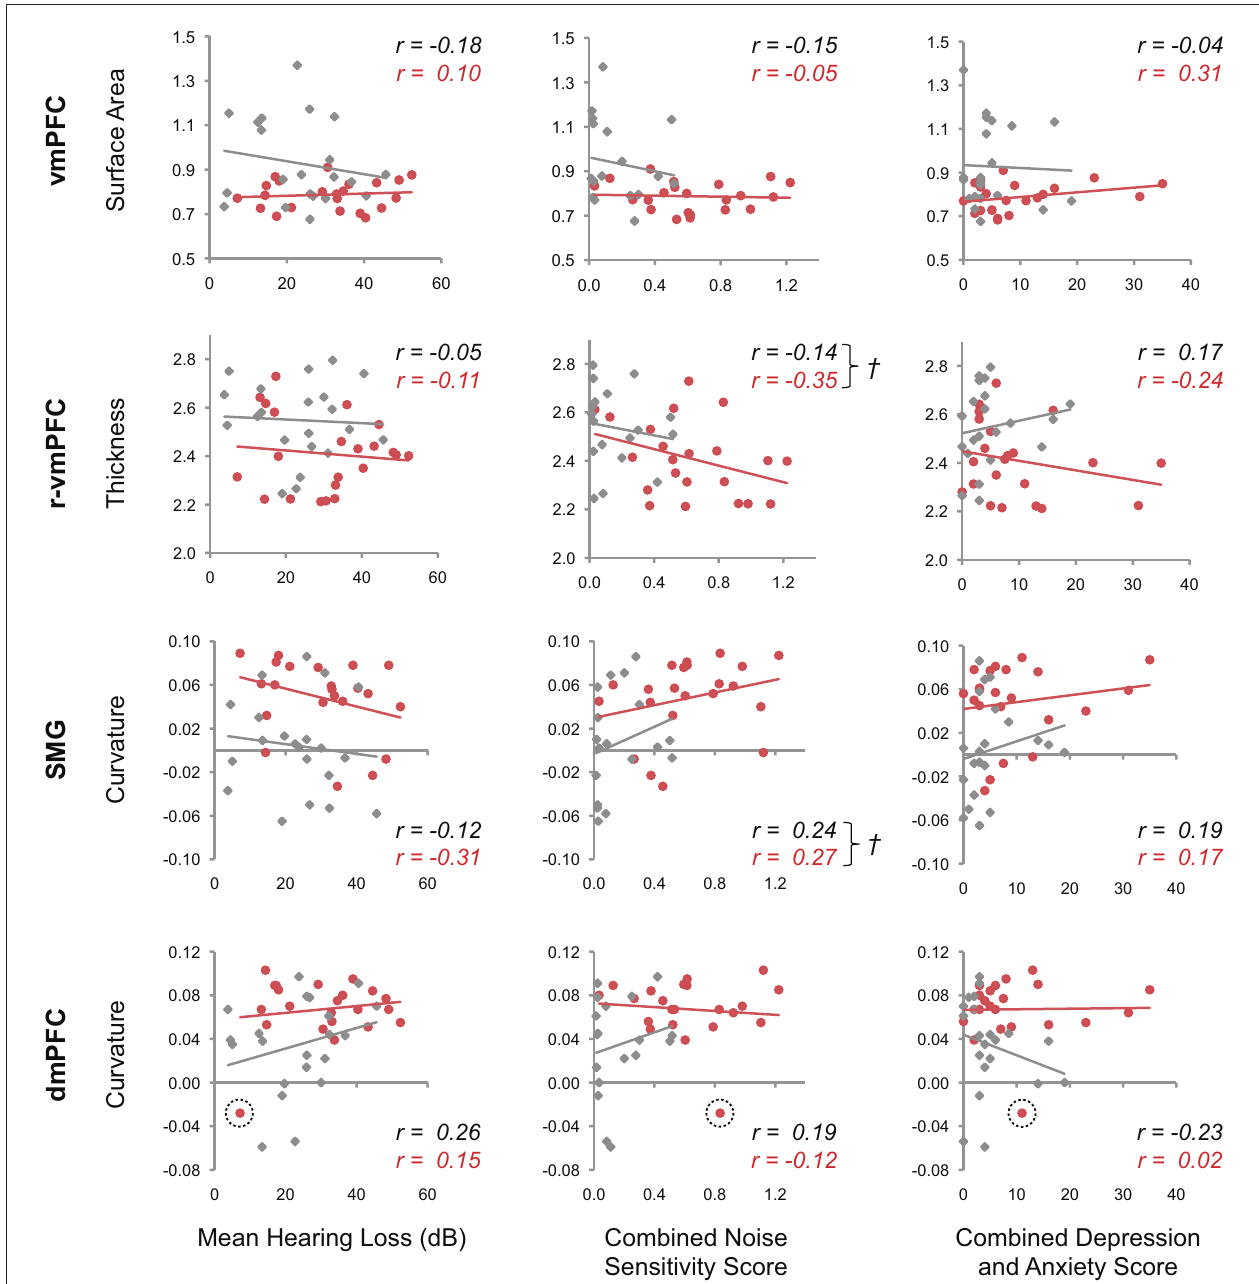
FIGURE 4 | Tinnitus-related cortical morphology and non-tinnitus factors. Scatterplots show the relationship between morphological features that best explain differences between tinnitus patients and controls in posterior vmPFC, rostral vmPFC, dmPFC, and SMG, and non-tinnitus factors. The mean value is plotted for each tinnitus patient (red) and control (gray) in each cluster, against mean hearing loss (left), noise sensitivity (middle), and combined depression and anxiety scores (right). Regression lines are plotted